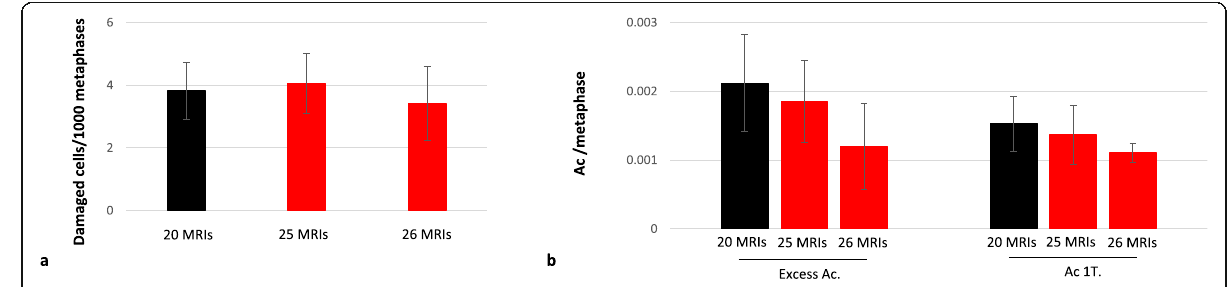
Fig. 4 Stabilisation of cytogenetic parameters after 20 MRI sessions. Further analysis was conducted after six supplementary MRI sessions. Evolution of damaged cells ( a ) and type E acentric fragments/1-T acentric fragments ( b ) between 20 and 25 – 26 MRI sessions. All parameters remained stable. Ac , Acentric fragment; MRI , Magnetic resonance imaging; T ,